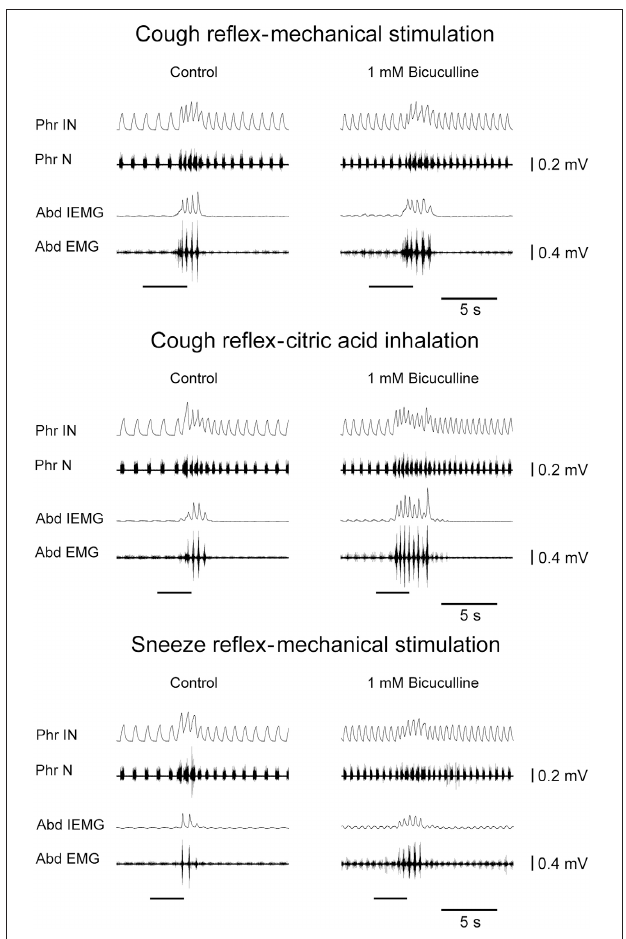
FIGURE 2 | Potentiating effects on the cough reflex and on the sneeze reflex ∼ 10min after bilateral microinjections of bicuculline into the cVRG of one anesthetized spontaneously breathing rabbit. Stimulation periods marked by filled bars. Phr IN, phrenic integrated neurogram; Phr N, phrenic neurogram; Abd IEMG, abdominal integrated electromyographic activity; Abd EMG, abdominal electromyographic activity.